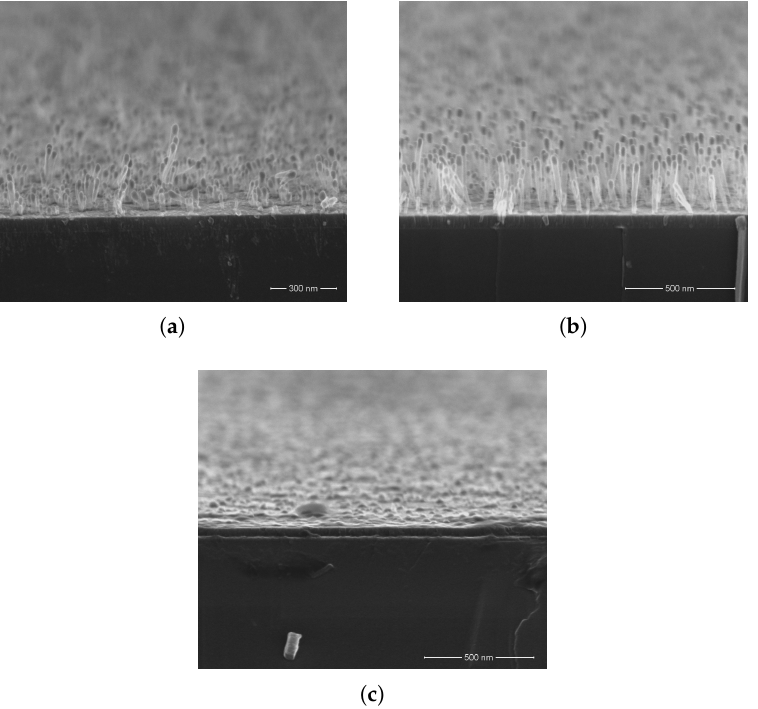
Figure 5. Cross-section SEM micrographs at 150,000 × magnification of CNT samples grown at 750 ◦ C and a fixed 70 sccm CH 4 gas flow rate while the NH 3 gas flow rate was varied as follows: ( a ) 25 sccm, ( b ) 50 sccm, and ( c ) 100